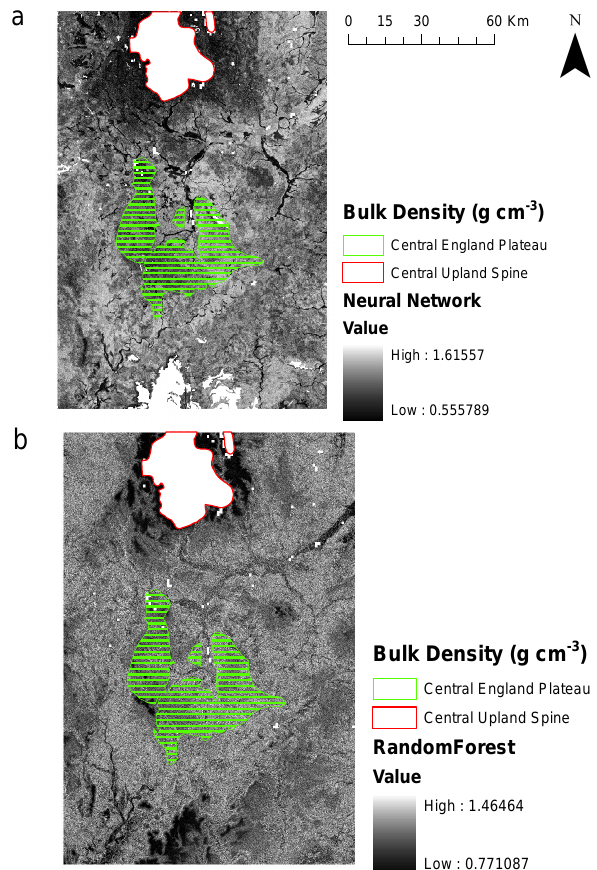
Fig. 2. Predicted bulk density across the landscape obtained from models built using the training dataset. (A) Artificial neural net- work, and (B) random forest.